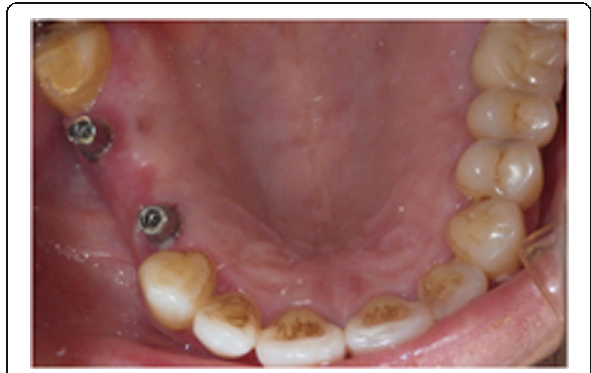
Fig. 2 Misaligned implants in the region of the premolar-molar area